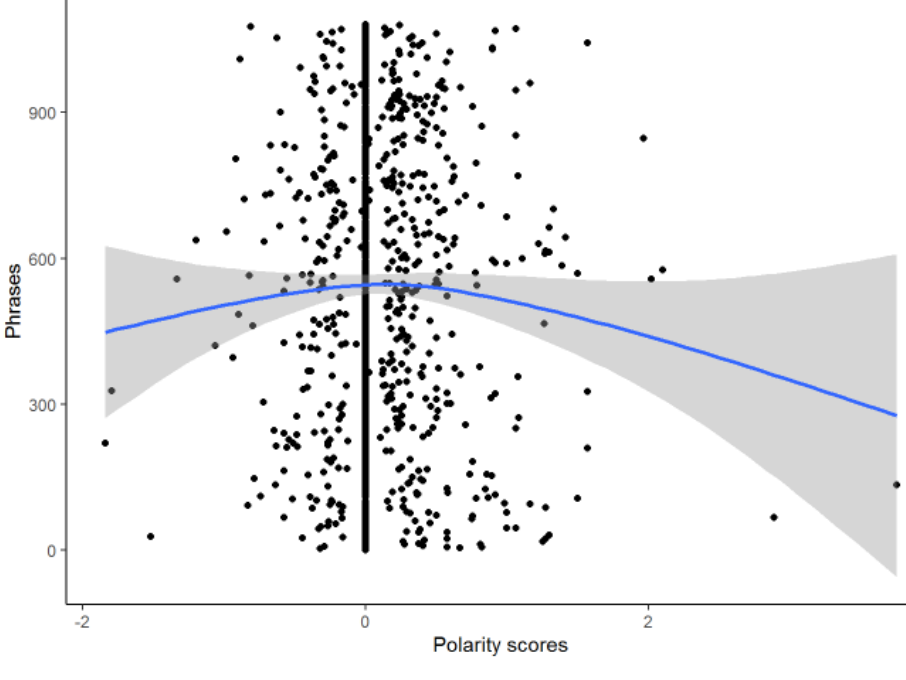
Figure 4. Polarity